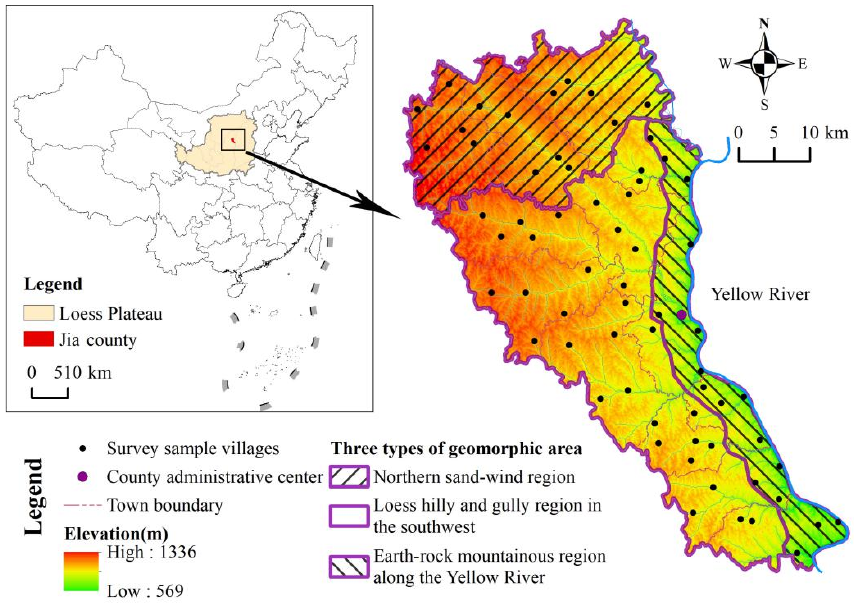
Figure 2. Map of the study area and sample